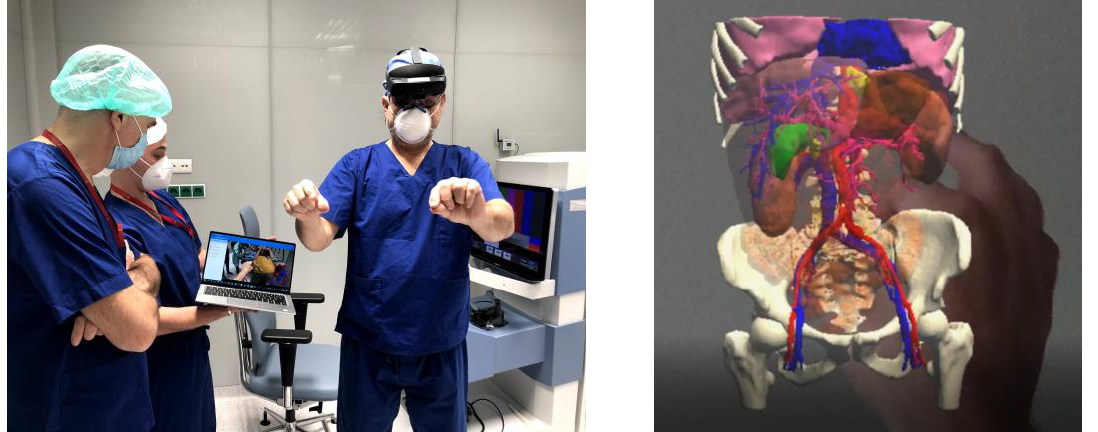
Figure 6. Preoperative 3D imaging before tumor resection with the Microsoft HoloLens. The top row of color-coded anatomical structures includes the aorta (red), inferior vena cava (blue), portal vein with its intrahepatic branches (purple, solid), the liver (purple, partially transparent), gallbladder (green), spleen (yellow), and kidneys (dark green). The bottom right model displays bone (white), abdominal aorta with its branches (red), inferior vena cava along with its tributaries and ascending into the right side of the heart (blue), portal system and its tributaries (purple), gallbladder (green), liver (light brown, partially transparent), spleen (brown, solid), lungs (pink), and one kidney (brown, solid). The bottom left image shows the HoloLens2 system being worn along with its live-streamed view onto a local computer.